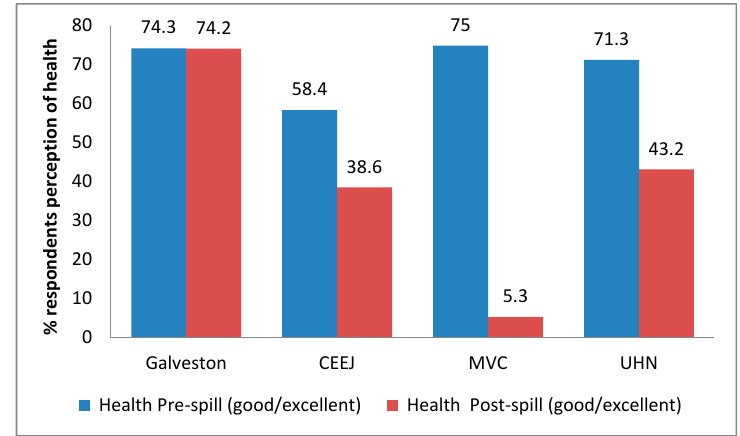
Figure 1. Perception of health pre- and post-spill. The difference in the proportion of respondents reporting “Good” or “Very Good” health among four communities was examined by χ 2 test. There was no difference among the communities before the spill ( p = 0.10); however, there was a significant difference after the spill ( p < 0.001). Center for Environmental and Economic Justice (CEEJ); Mississippi Vietnamese Fishing Community (MVC); United Houma Nation (UHN).